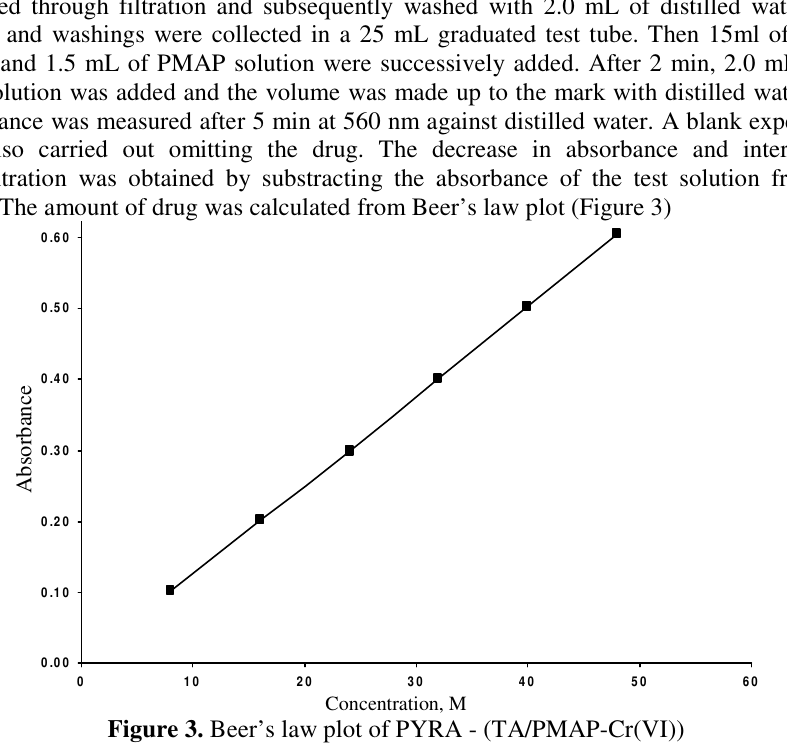
Figure 3. Beer’s law plot of PYRA -